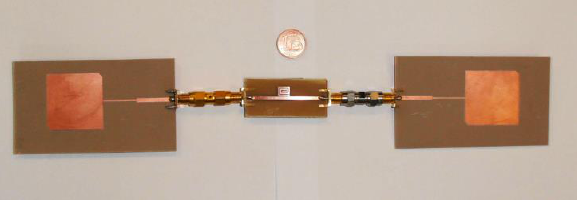
Figure 7 Photo of a single-bit chipless tag equipped with two patch antennas with modified corners.